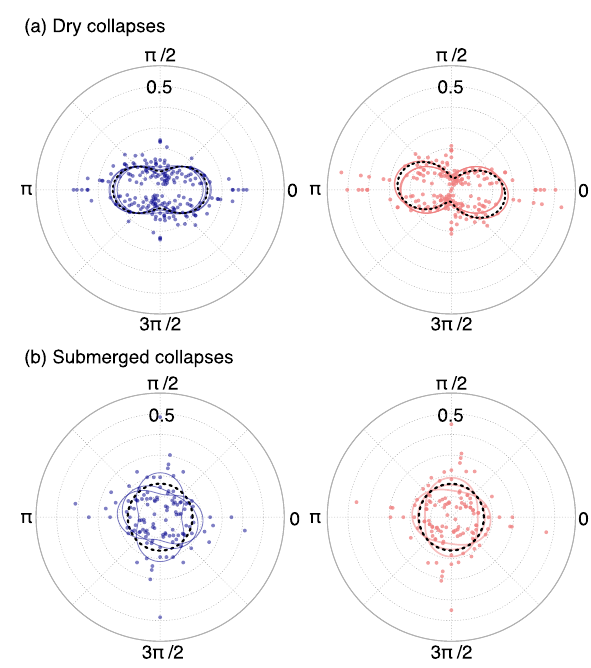
Figure 3. Polar representation of the probability density of grain orientations around an angle # comparing the initial (right) and final (left) configuration. (a) Orientations for the dry collapses; and (b) Orientations for the submerged collapses. The symbols correspond to P # ( # ), the solid lines present the harmonic fit for each experiment (Eq. 2), and the black dashed line presents the harmonic fit for all